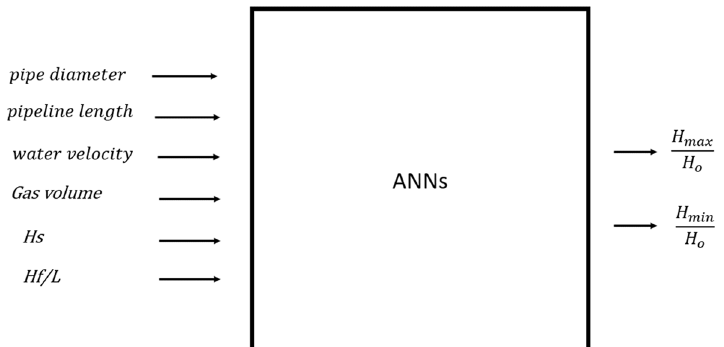
Fig. 4 Inputs and outputs for the 2nd artificial neural